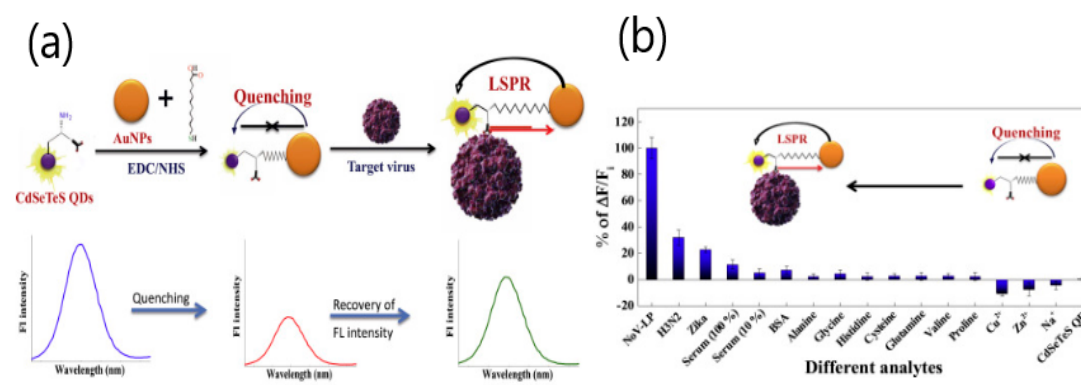
Figure 8. ( a ) Schematic diagram for the preparation of CdSeTeS QD (quantum dot)/AuNPs’ nanocomposites and their sensing mechanism toward norovirus-like particles (NoV-LPs’) detection. The sample solution was excited at 450 nm, and the fluorescence intensity was measured in a range of 500–700 nm. The close covalent attachment of AuNPs with CdSeTeS QDs effectively quenched the fluorescence signal, which was recovered after NoV-LPs’ entrapment. ( b ) Selectivity test of the Ab-CdSeTeS QDs/AuNPs’ nanobiosensor with 30 μ g mL − 1 of influenza, 104 PFU (plaque forming units) mL − 1 of Zika viruses, and other